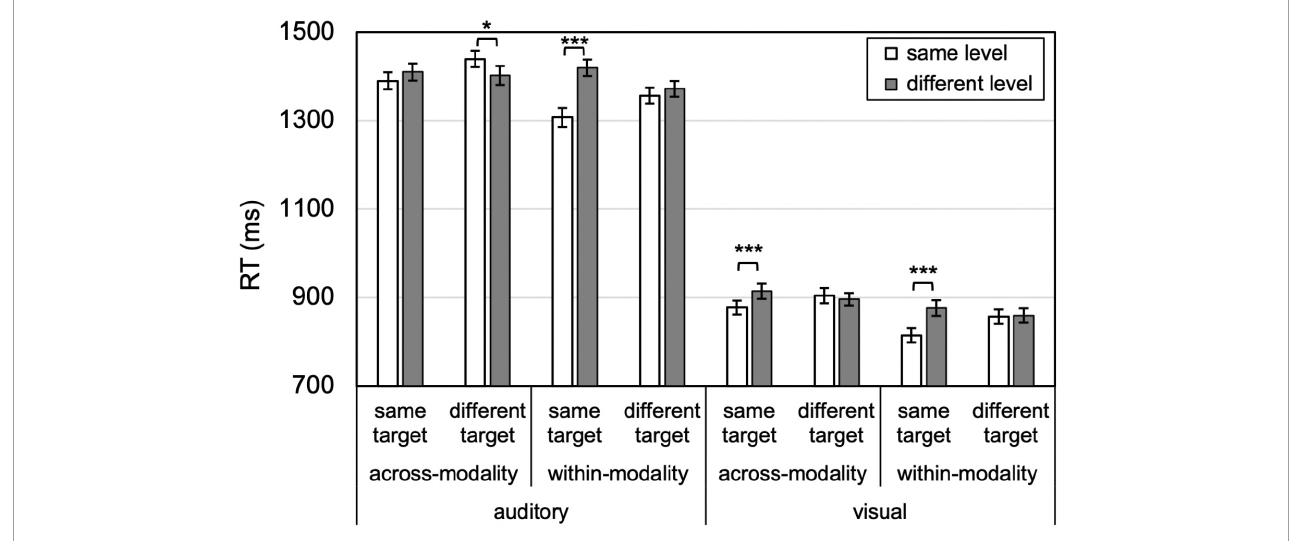
FIGURE3 Attentional persistence to level is absent (for different targets, no benefit for same-level compared to different-level), whereas identity priming is more prevalent (for same targets, compare same- to different-level). Error bars reflect SE s adjusted for within-subjects comparisons, * p < 0.05, *** p ≤ 0.001.